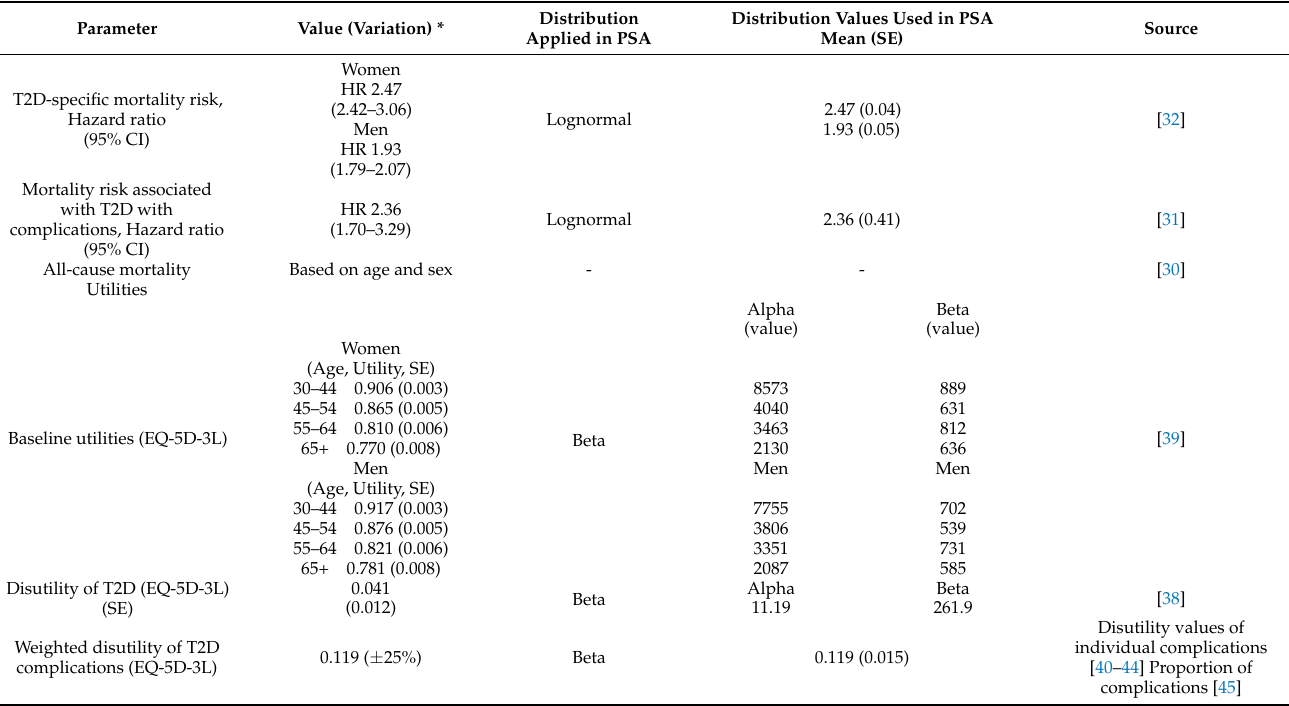
Table 3. Parameters applied in the Markov model, their distributions, and the values used to estimate the distributions.